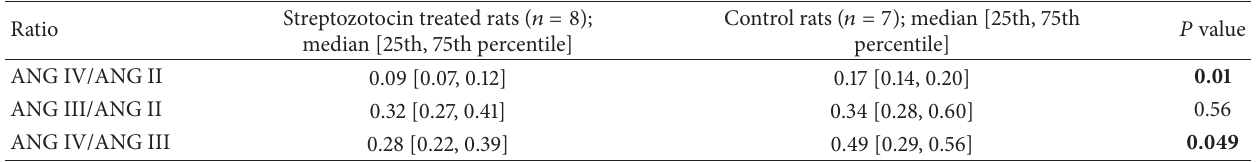
Table 5: Ratios of concentrations of the products of classical pathway of exogenous ANG I (1 𝜇 M) metabolism by aorta fragments